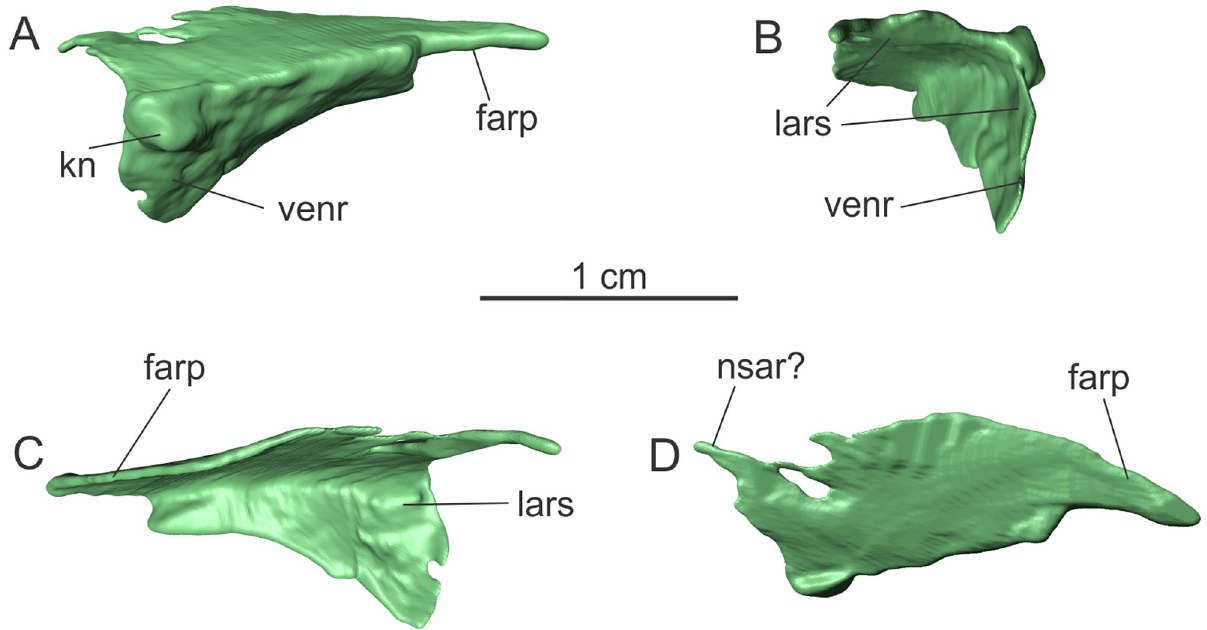
Fig 4. Left prefrontal of the specimen MCP-3845-PV of Saturnalia tupiniquim in lateral (A), anterior (B), medial (C), and dorsal (D) views. Abbreviations : farp— posterior process for the articulation with the frontal; kn— knob; lars— articulation surface with the lacrimal; nsar— articulation surface with the nasal; venr— ventral